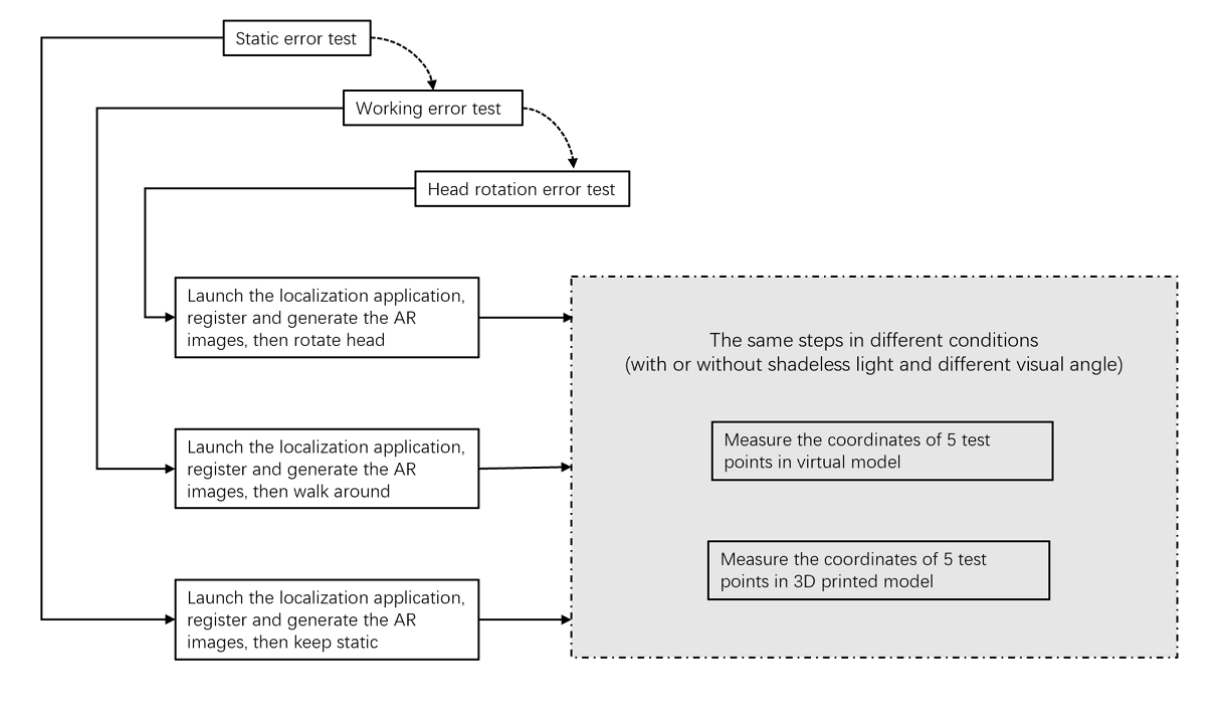
Figure 4. Workflow of the test. AR: augmented reality; 3D: three-dimensional.